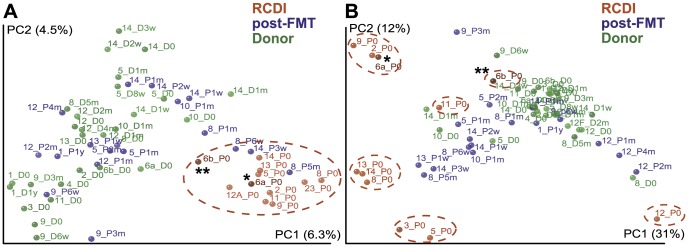
Unscaled principal coordinate analysis (PCoA) plots showing unweighted (A) and weighted (B) UniFrac analysis of RCDI (red) and post-FMT (blue) patient and healthy donor (green) samples.RCDI patient samples are circled in red. RCDI samples from patient #6a (*), who experienced antibiotic-induced relapse and was treated by FMT again as patient #6b (**) are marked in dark red. Sample names indicate case numbers, patient or donor source and time point of collection ("0" time point refers to pre-FMT sampling time points; other time points are abbreviated as weeks [w], months [m] and year [y]).